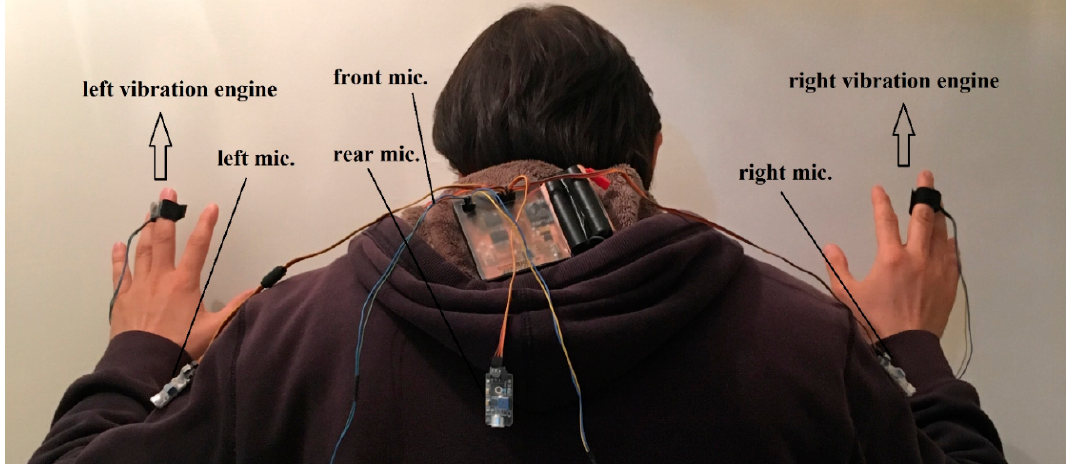
Figure 1. In testing our wearable device on the user in real time.